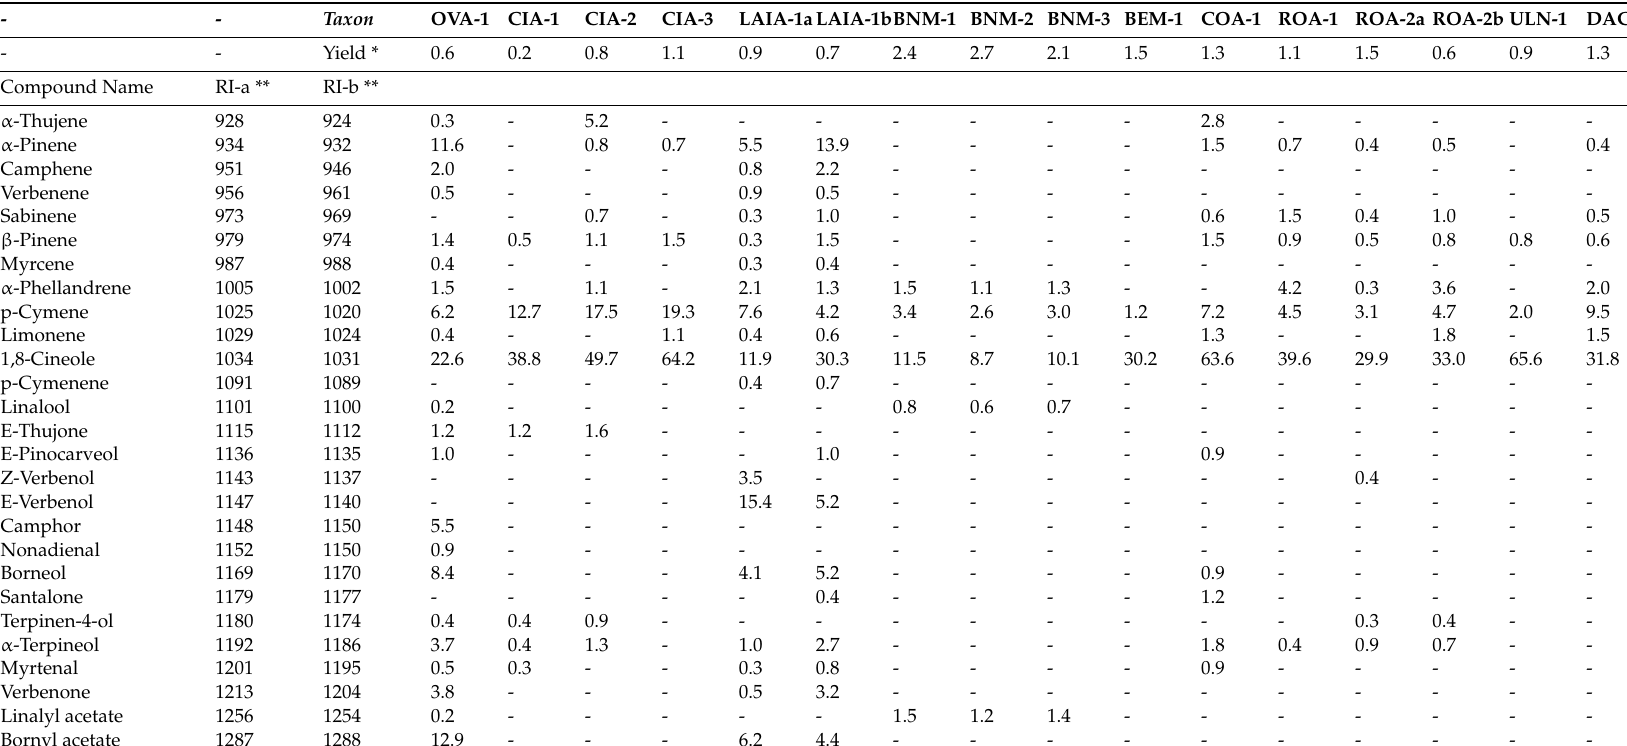
Table 2. Chemical character of essential oils from taxa a ffi liated with P. ovalifolia , and P. rotundifolia . OVA = P. ovalifolia (actual), ROA = P. rotundifolia (actual), CIA = P. cineolifera , LAIA = P. latifolia , BNM = P. sp. Barren Mountain, BEM = P. sp. Blue Mountains, COA = P. cotinifolia , ULN = P. sp. Ulan, DAC = P .